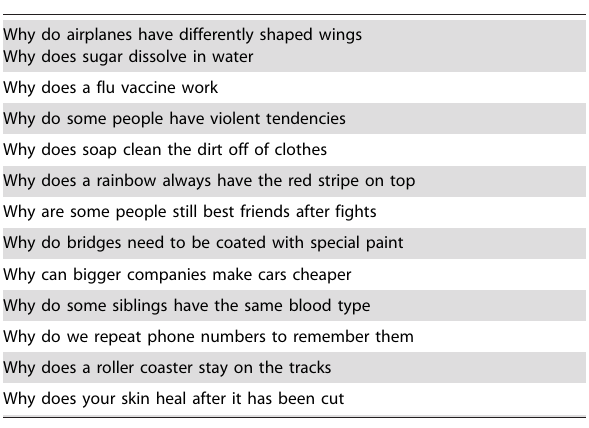
Table 1. List of all search topics.